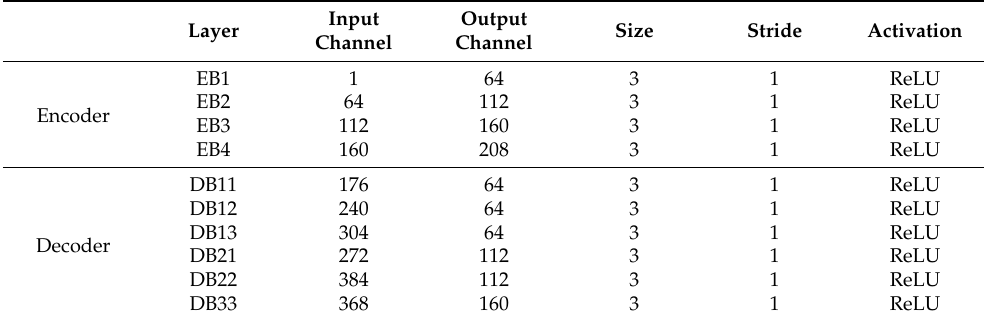
Table 1. Model configurations for encoder and decoder network. EB1 denotes the encoder block in the first row, DB11 denotes the decoder in the first row and the first column.